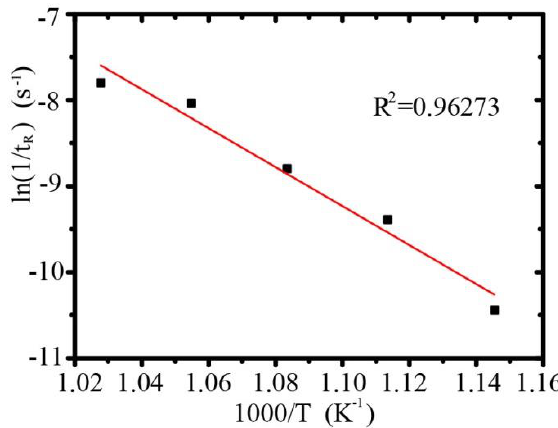
Figure 9. Relationship between ln(1 / t R ) - 1000 / T of 60% cold drawn Cu–Cr–In alloy.